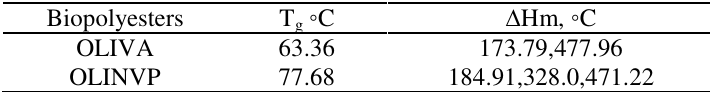
Figure 10. The TGA-DTA curve for OLINVP Table 4. DSC